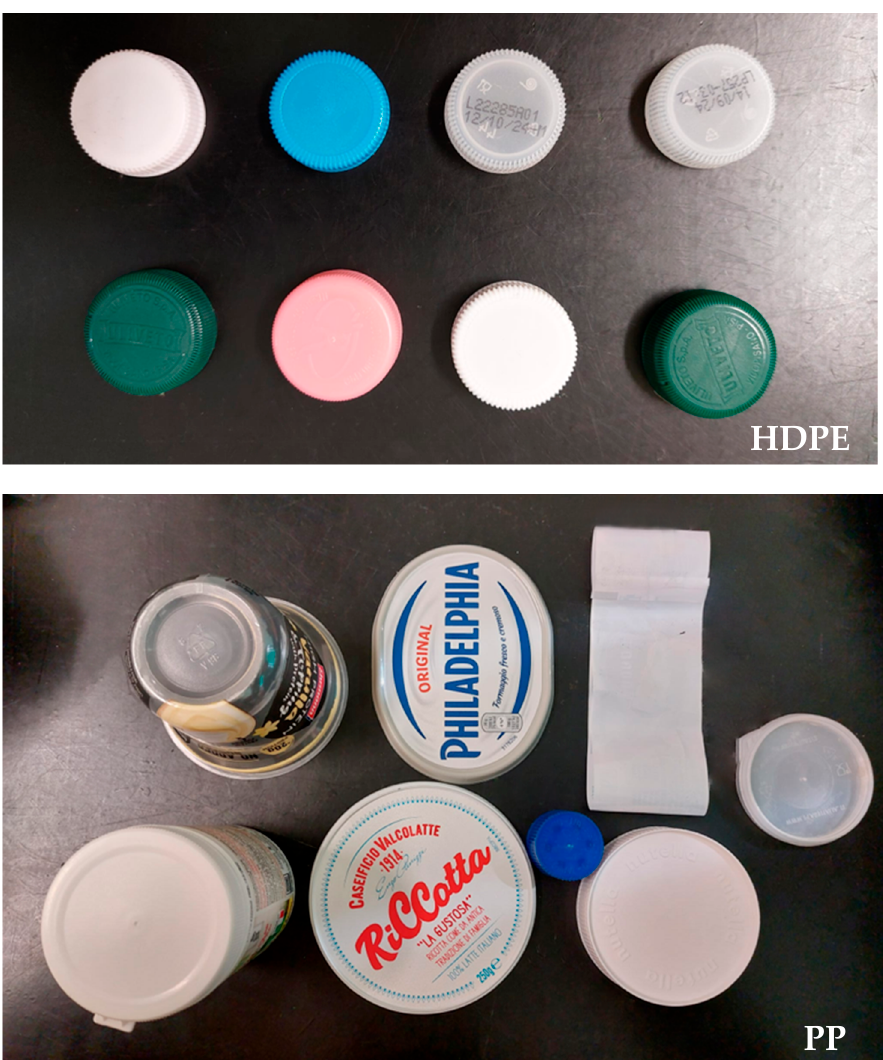
Figure 8. The plastic samples used for the test of the microplastic sensor.